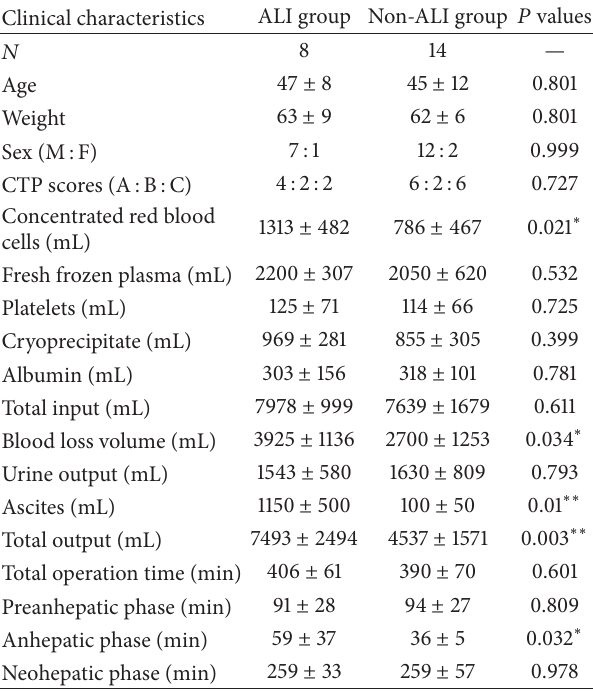
Table 1: Clinical characteristics of the ALI group and non-ALI group during the peri-OLT period in